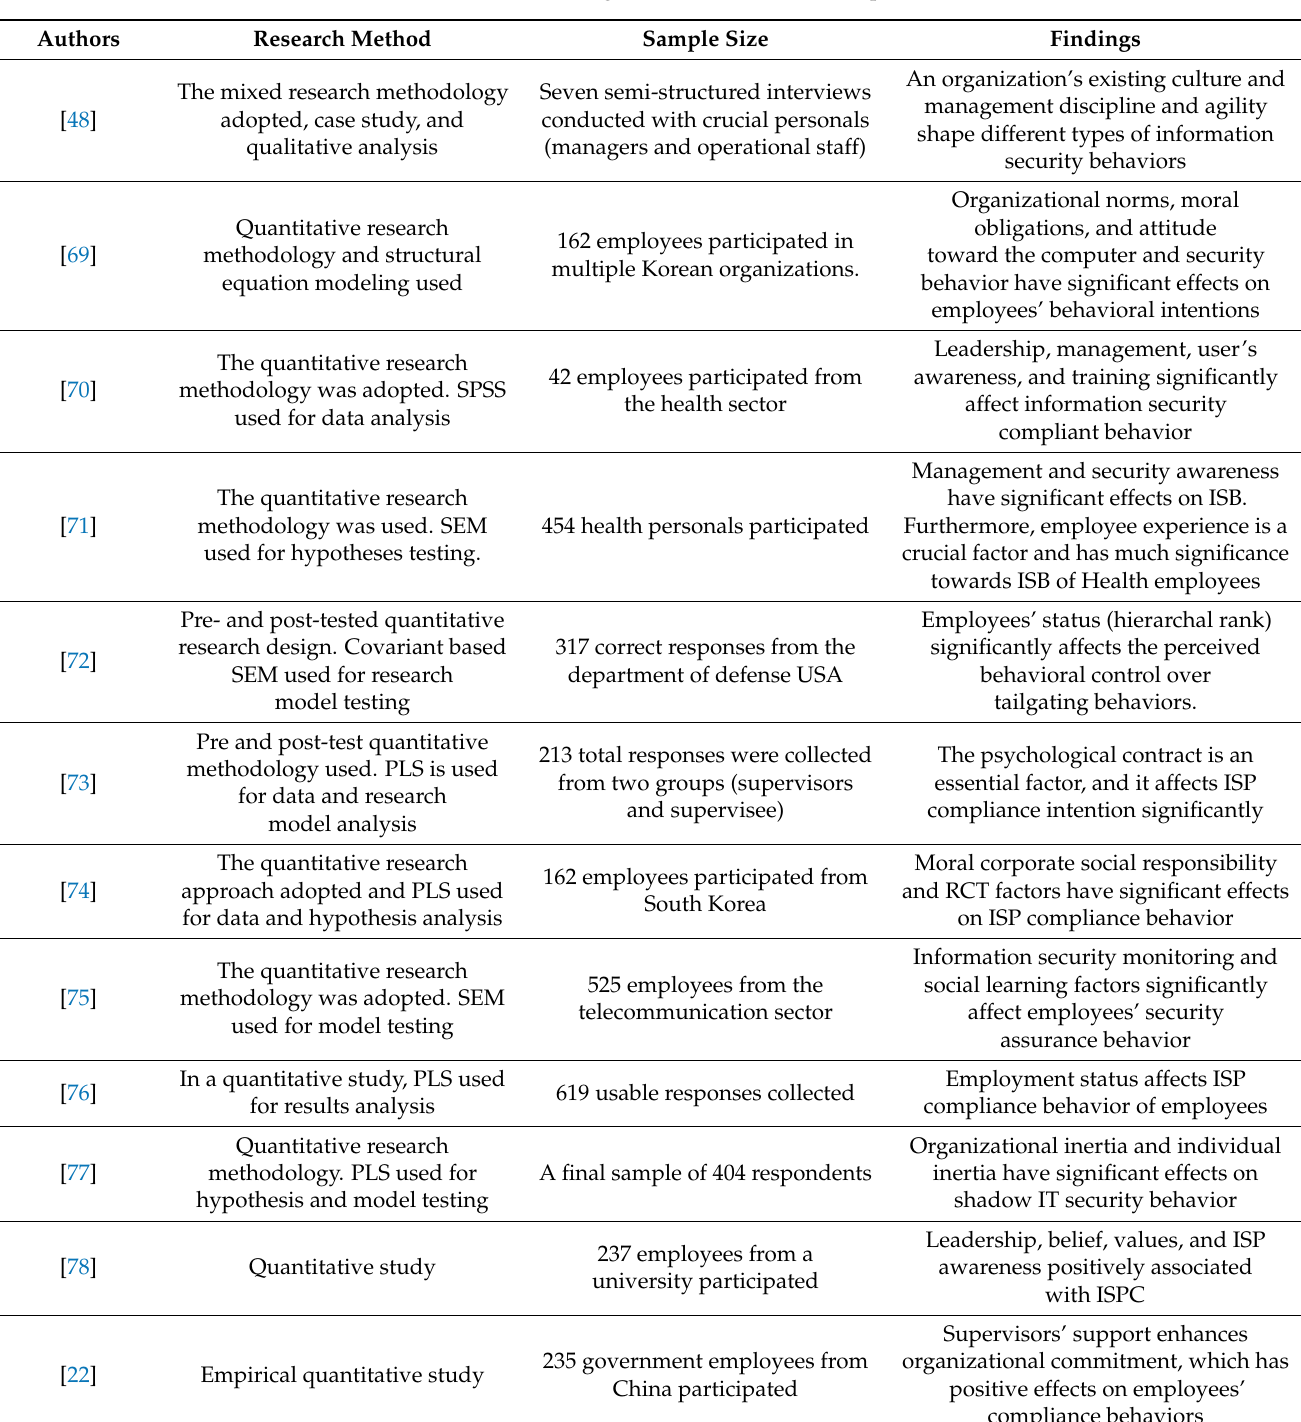
Table 8. Studies on management behaviors and